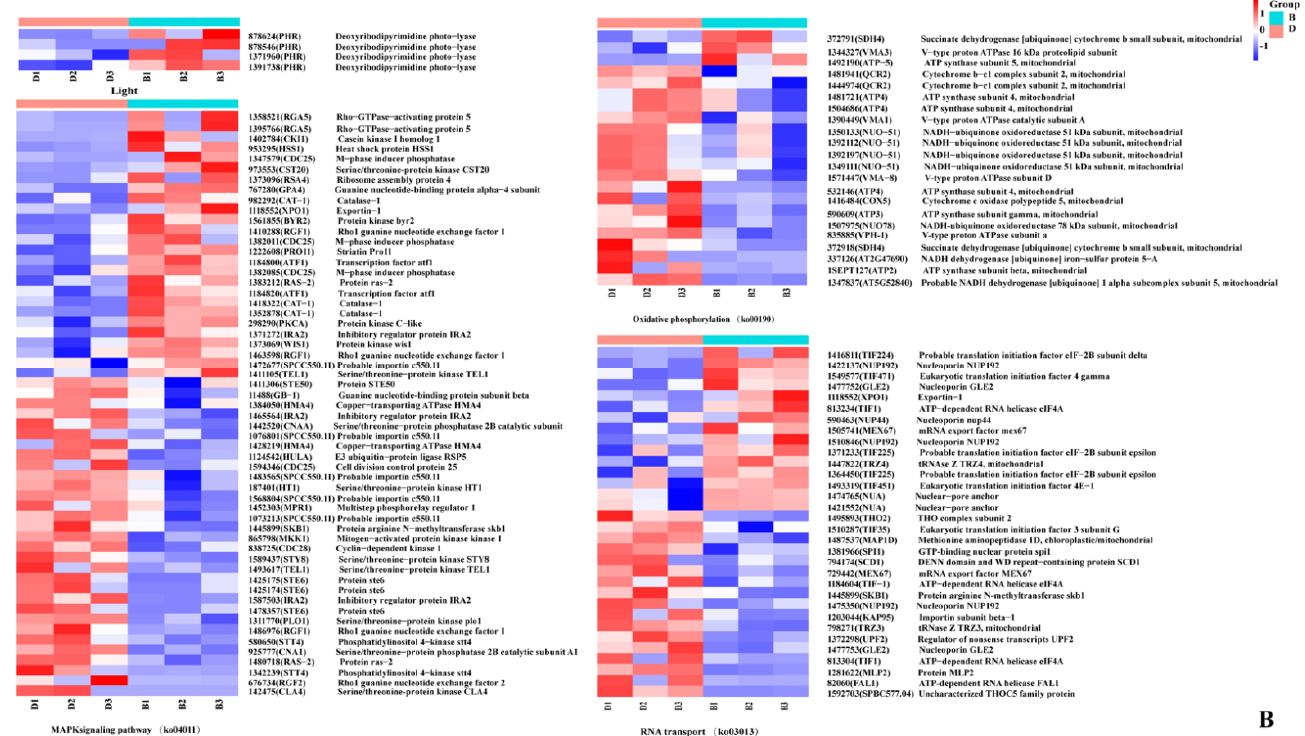
Figure 9. Genes involved in primordium formation in P. eryngii . ( A ). The DEGs between darkness and red light. ( B ). The DEGs between darkness and blue light. The gene ID number and the name of the homolog are indicated on the right side of each subplot. The gene expression values (FPKMs) were transformed to Z-score values.